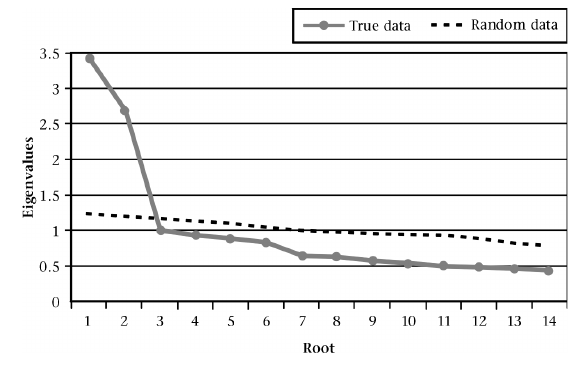
Figure 2: Scree-plot (Asian group)